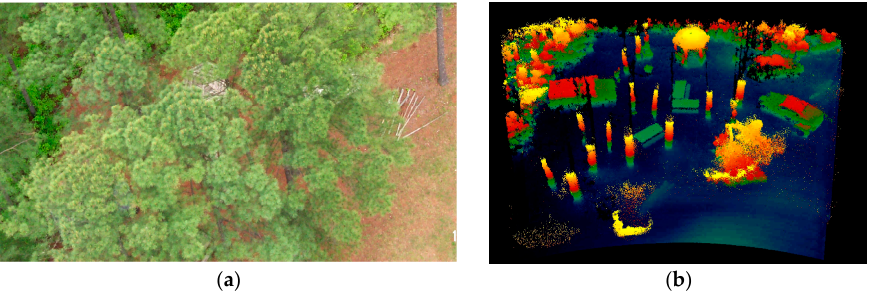
Figure 9. ( a ) Forest canopy as viewed from a nearby tower ( b ) Composite lidar image obtained by